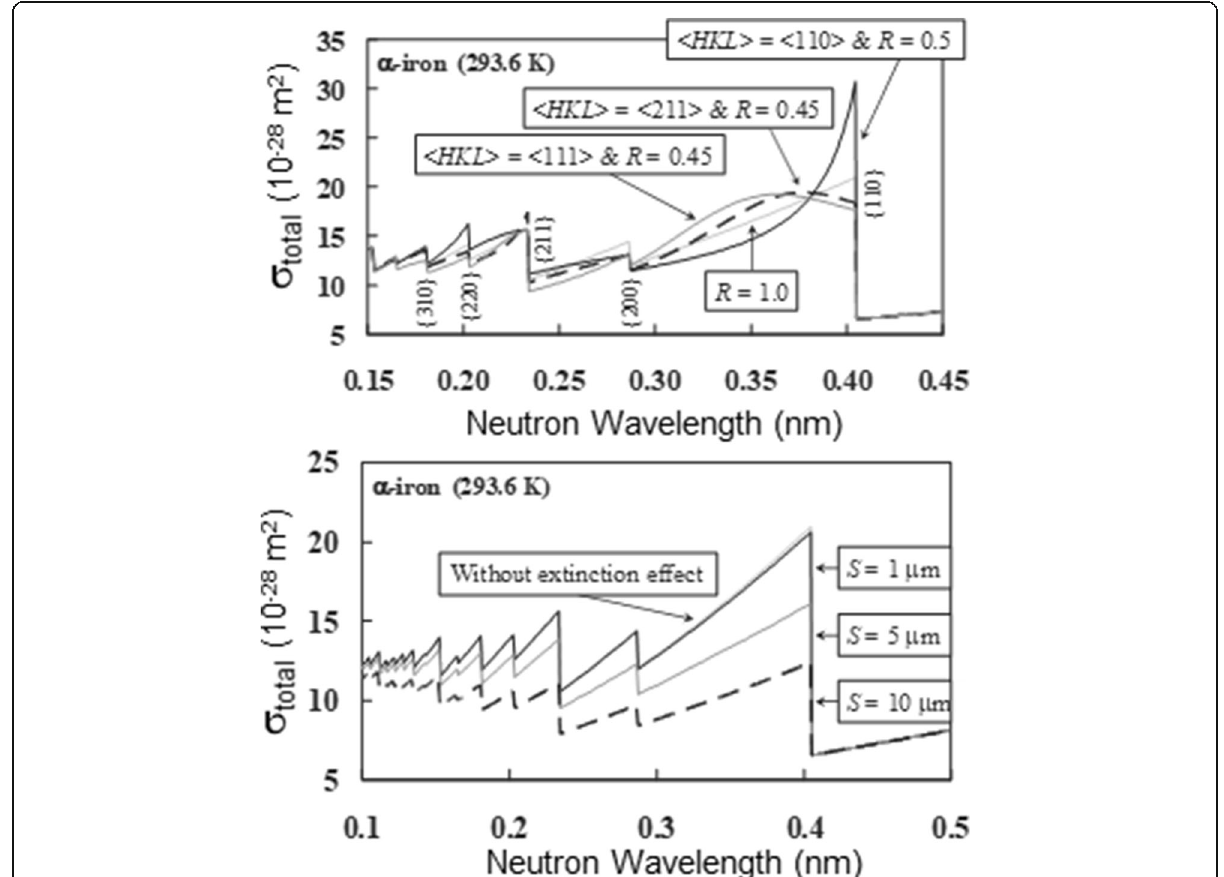
Fig. 9 Cross-section change due to ( a ) anisotropy and ( b ) crystallite size